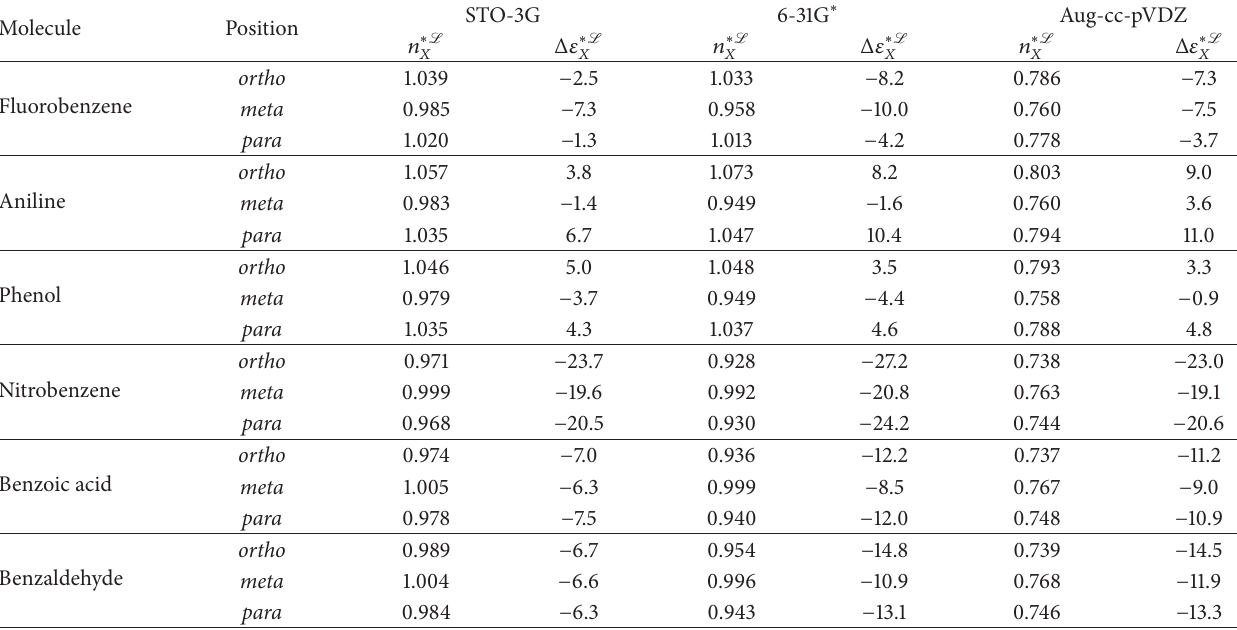
Table 2: Occupation numbers (11) and differences between the highest NO “energies” (15) in [kcal ⋅ moL − 1 ] for benzene and its derivatives, calculated within representation of “geometrically” orthogonalized atomic orbitals. For asymmetric species, the position refers to carbon